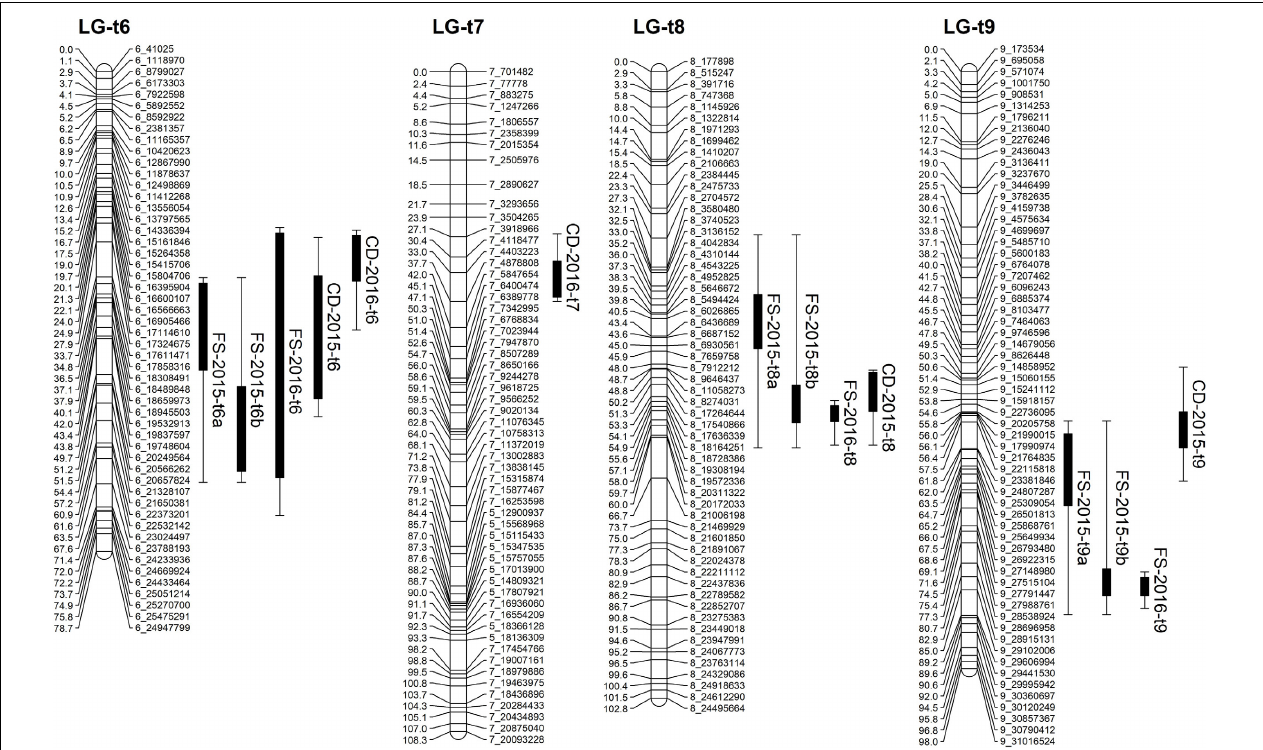
FIGURE 5 | Mapping QTLs with foliar symptoms and canopy damage on the trifoliate orange genetic linkage map. Thick bars on the right side of each LG indicate confidence interval of QTLs with LOD score above threshold and flanking error bars indicate extension of QTL region at LOD score